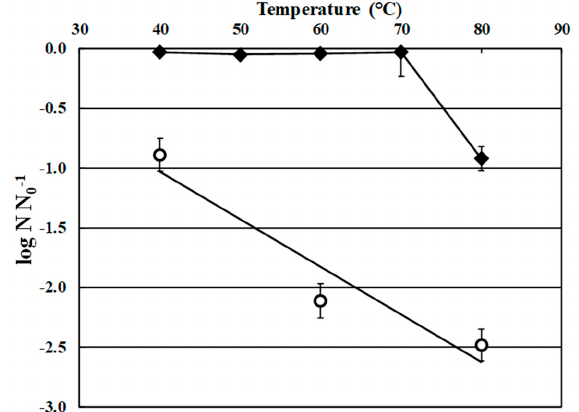
) and comparison with (cid:35)